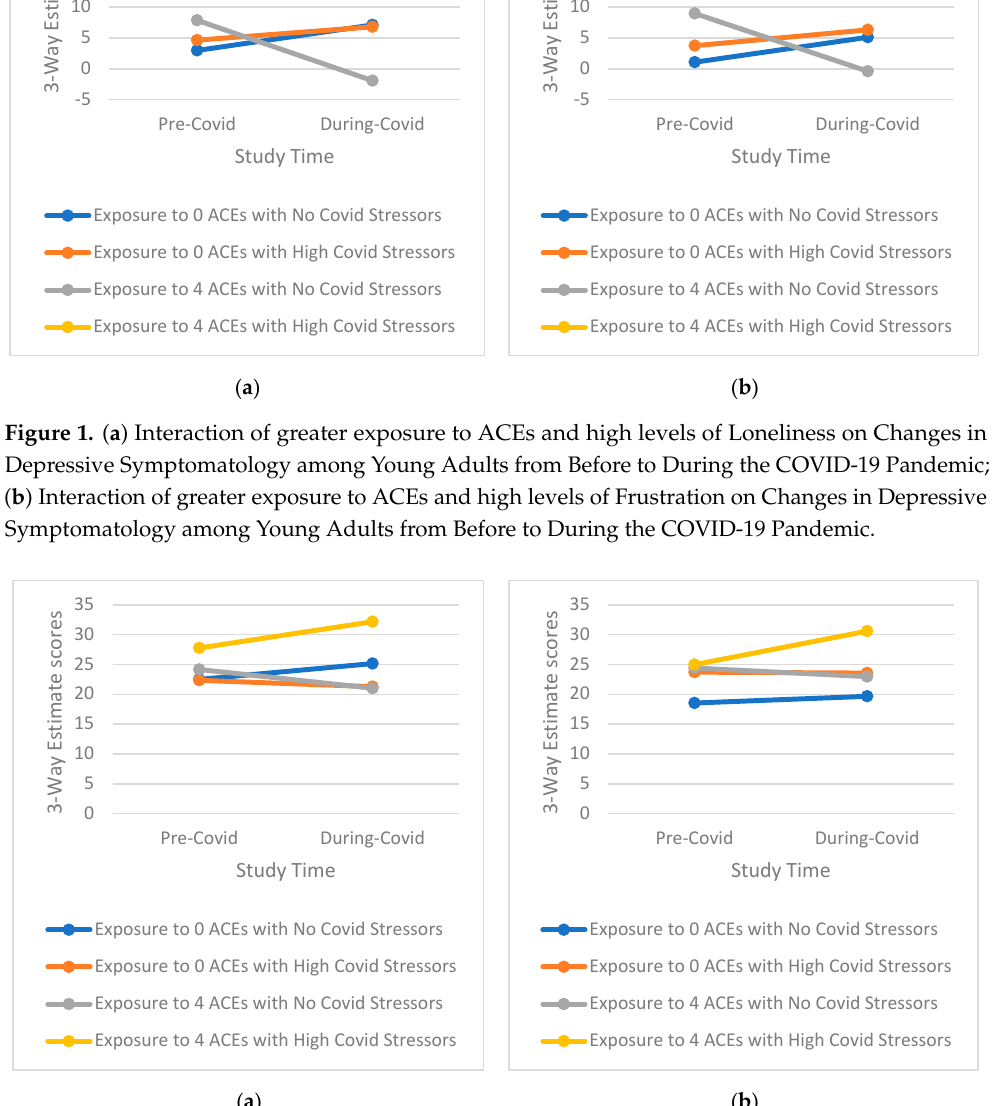
Figure 3. ( a ) Interaction of greater exposure to ACEs and high levels of Loneliness on Changes in Hostility Symptomatology among Young Adults from Before to During the COVID-19 Pandemic; ( b ) Interaction of greater exposure to ACEs and low levels of Physical Activity on Changes in Hos- tility Symptomatology among Young Adults from Before to During the COVID-19 Pandemic.